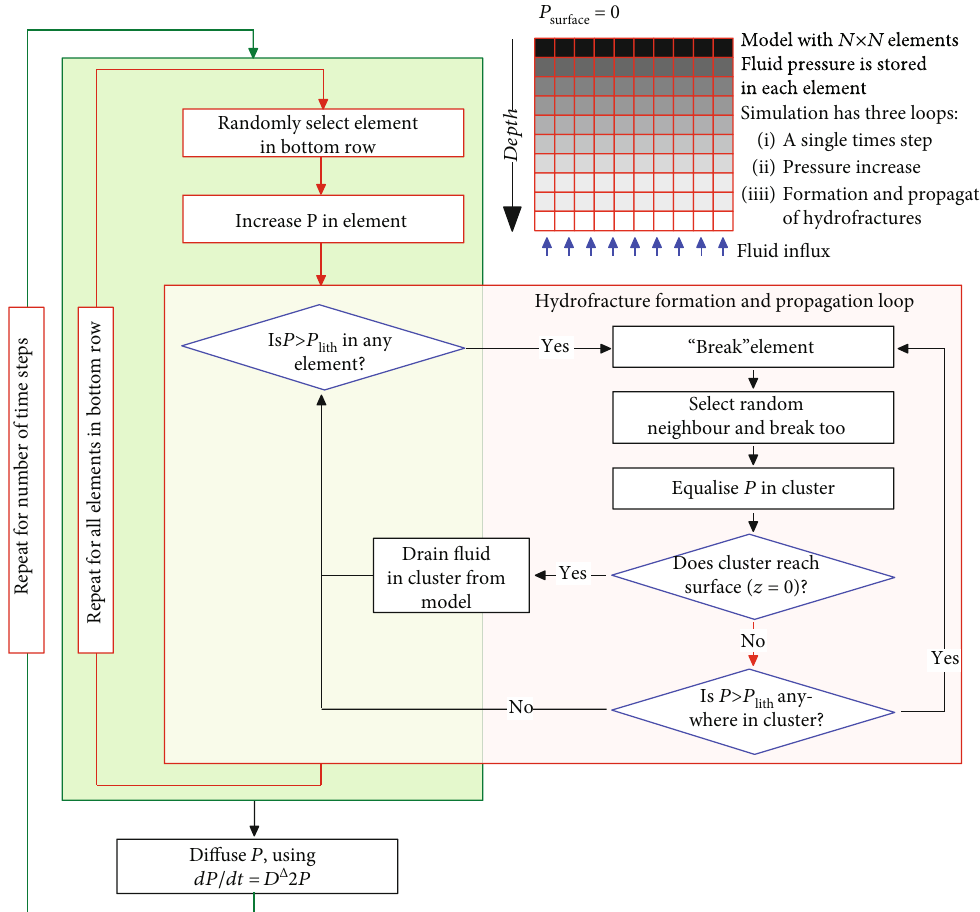
Figure 2: Flow diagram of the numerical simulations. The model consists of a rectangular grid of N × N elements in which the local fl uid pressure in excess of the hydrostatic fl uid pressure is recorded. In fl ux of fl uid from below is simulated by an incrementally increasing the pressure in the bottom row of the model. The main loop consists of adding fl uid and letting the pressures di ff use. Adding pressures is carried out one randomly selected element at a time after which possible hydrofracture initiation is considered. If this occurs, a subloop is initiated for the further propagation of the